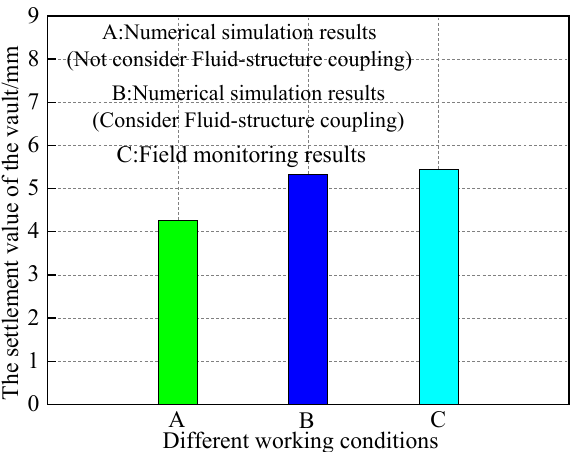
Figure 8. The vault settlement under different working conditions .